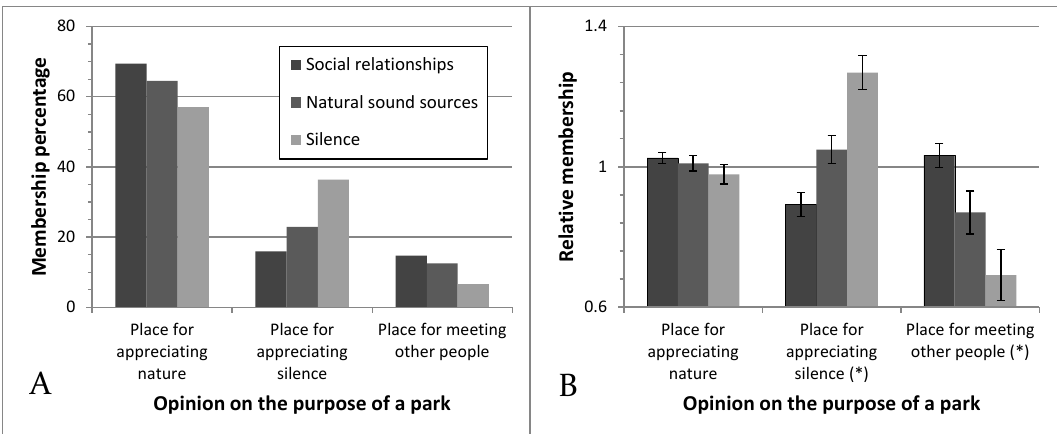
Figure 3. Membership of tranquility viewpoint groups, as a function of the response to the direct question on park purpose: ( A ) percentages of people responding to an opinion statement in each tranquility group; ( B ) relative membership to tranquility group per opinion on the park purpose. In ( B ): whiskers correspond to one standard error, and stars indicate statistically significant difference confirmed by analysis of variance between tranquility